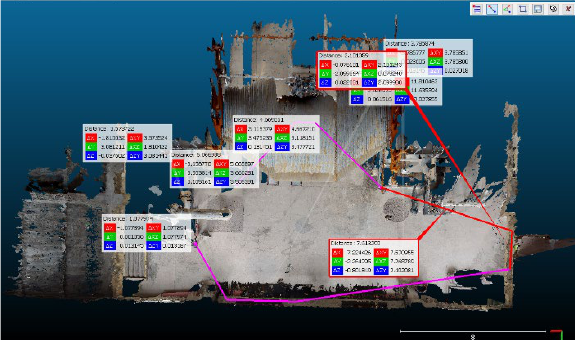
Figure 14. Measured control distances on Matterport point cloud The same distances were measured by tape. The results of measurements and their comparison to tape measurements are presented in Table